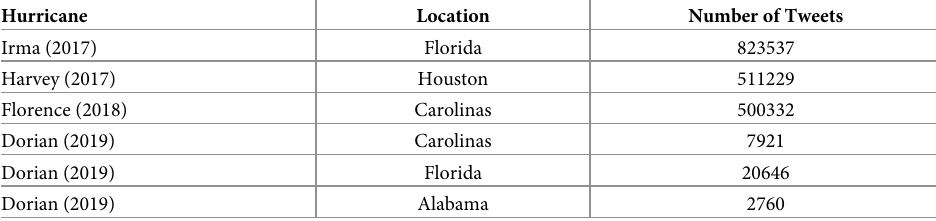
Table 1. Hurricane data.